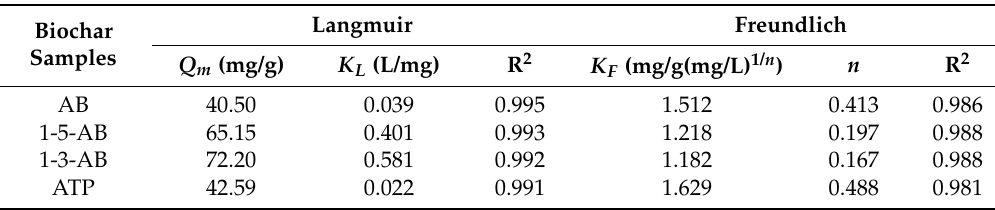
Table 3. Isotherm parameters for the adsorption of RBR.